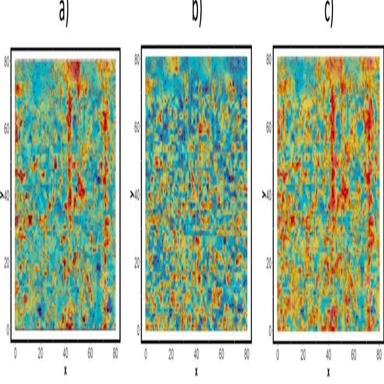
Combined EBSD and nanoindentation phase maps; a) Hardness over EBSD, b) Modulus over EBSD, c) Phase over EBSD. X and Y coordinates are presented in µm.